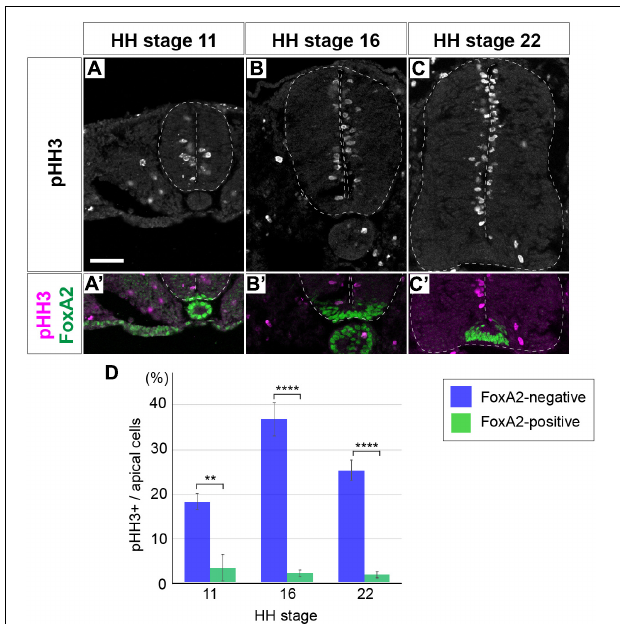
FIGURE 1 | Floor plate cells are not proliferative unlike the neural progenitor cells of other domains. (A–C’) Expression of pHH3 and FoxA2 in neural tube sections at HH stage 11 (A,A’) , 16 (B,B’) , and 22 (C,C’) . pHH3-positive cells were not detected in the FP, where FoxA2 is highly expressed (A’,B’,C’) . (D) Quantitative data of the ratio of pHH3-positive cells over the apical cells in the FP and in other domains of the neural tube. Scale bar = 50 µ m. ∗∗ p < 0.01, ∗∗∗∗ p <